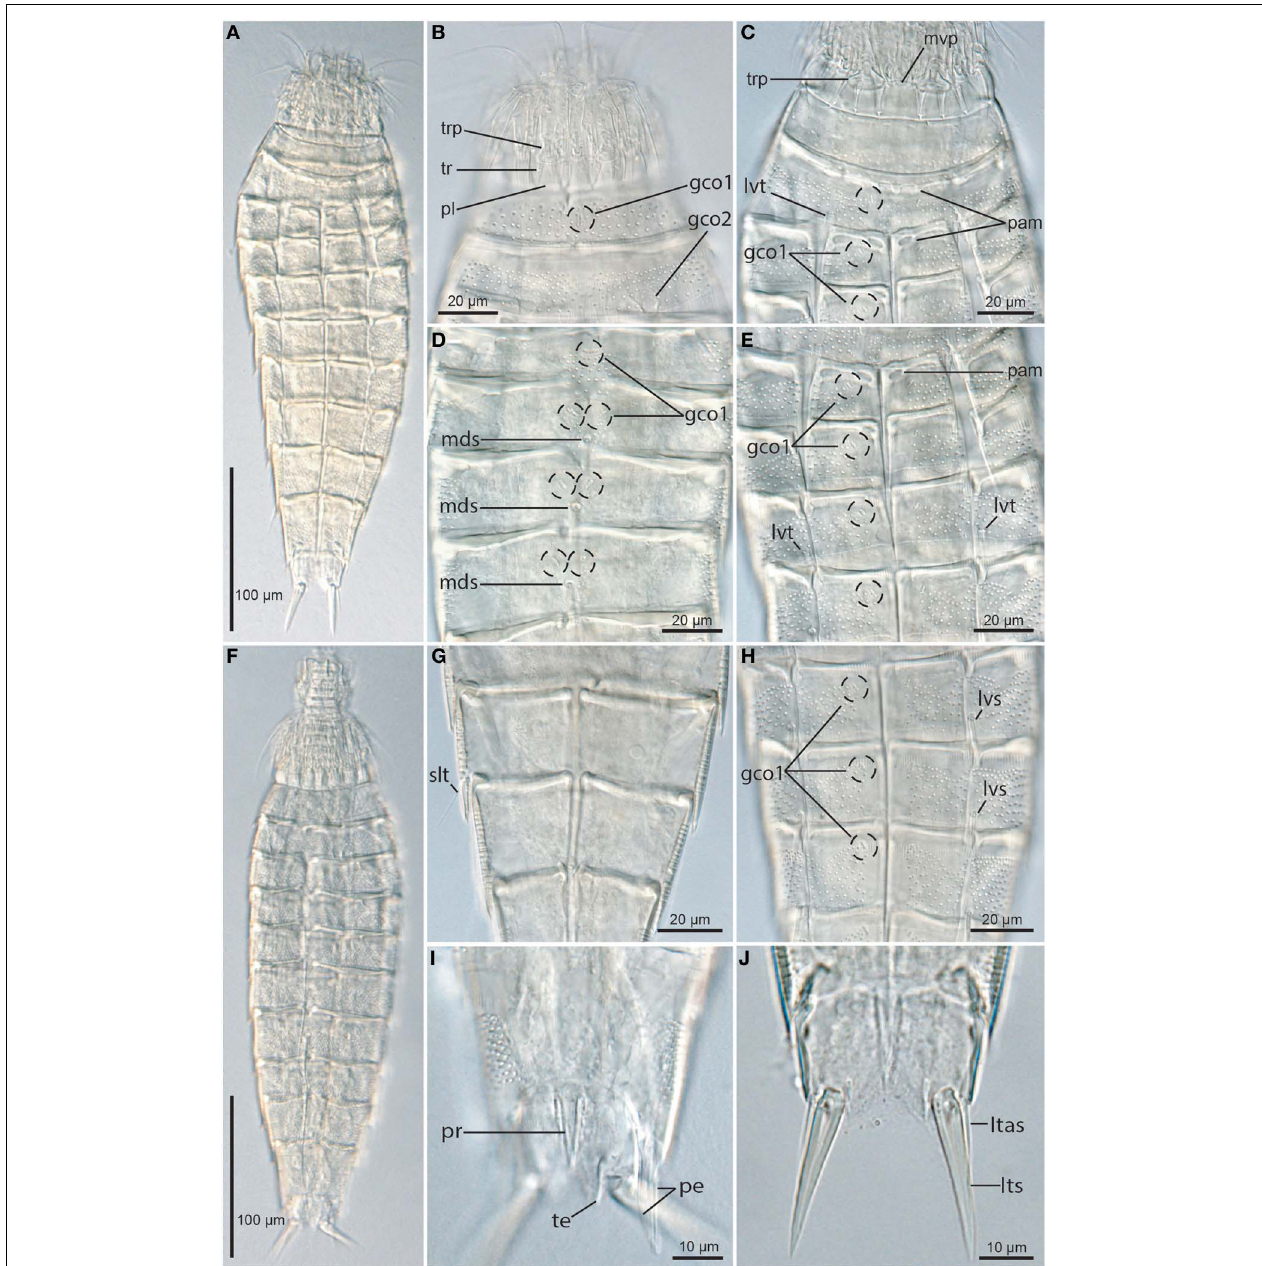
FIGURE 4 | Light micrographs showing overviews and details of trunk morphology in Echinoderes augustae sp. nov. (A–E) and (G,H) female holotype (ZMUC KIN-705); (F,I). Male paratype (ZMUC KIN-710); (J) non-type female. (A) Ventral overview. (B) Partly retracted head, neck and segments 1 to 2, dorsal view. (C) Neck and segments 1 to 3, ventral view. (D) Segments 3 to 6, dorsal view. (E) Segments 3 to 6, ventral view. (F) Dorsal overview. (G) Segments 8 to 9, focusing on sublateral tubule on segment 8.